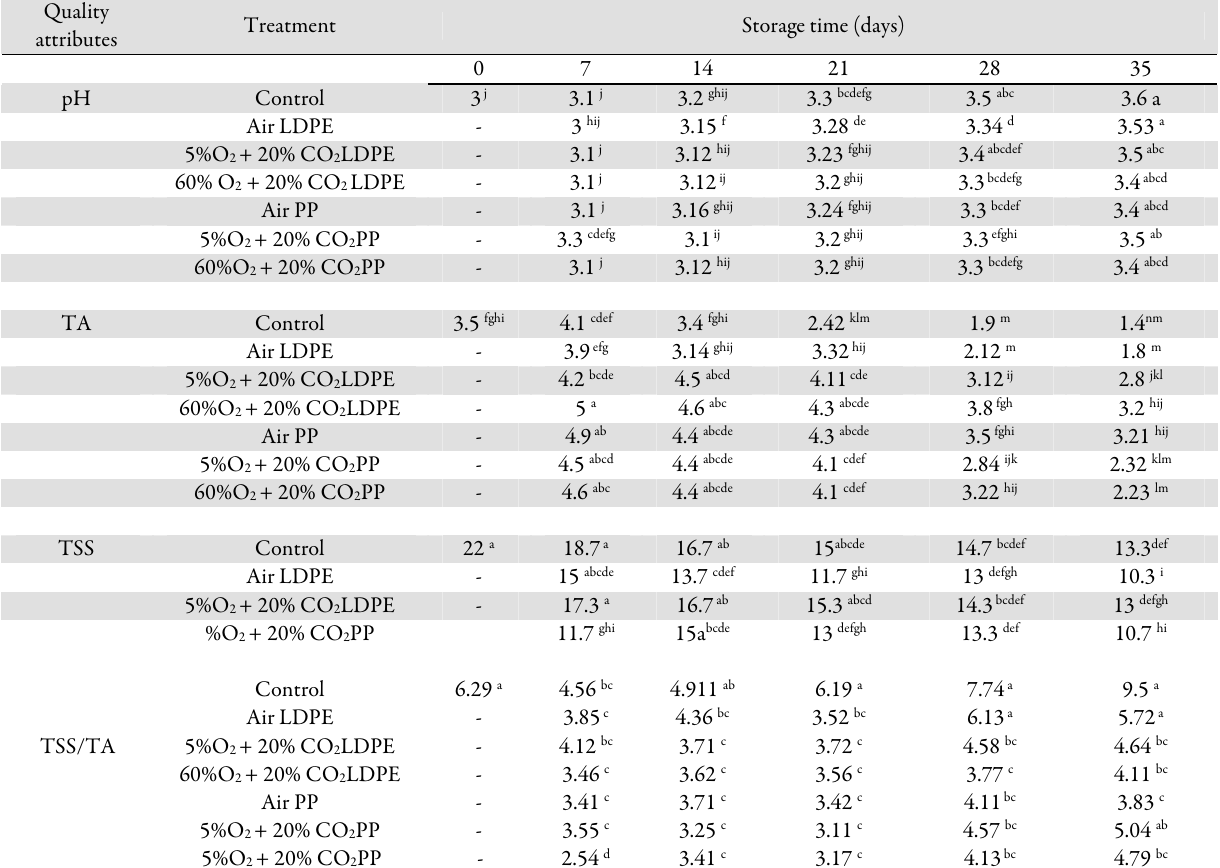
Table 2. Changes in pH, TA, TSS and TSS/TA of cornelian cherry fruits before (day 0) and after 5 weeks of storage at 1 °C packaged in two types of polymeric films: LDPE: low density polyethylene, PP: polypropylene using three gas combinations: 5%O 2 + 20%CO 2 + 75%N 2 , 60%O 2 + 20%CO 2 + 20%N 2 , and Air compared with control (unpackaged)